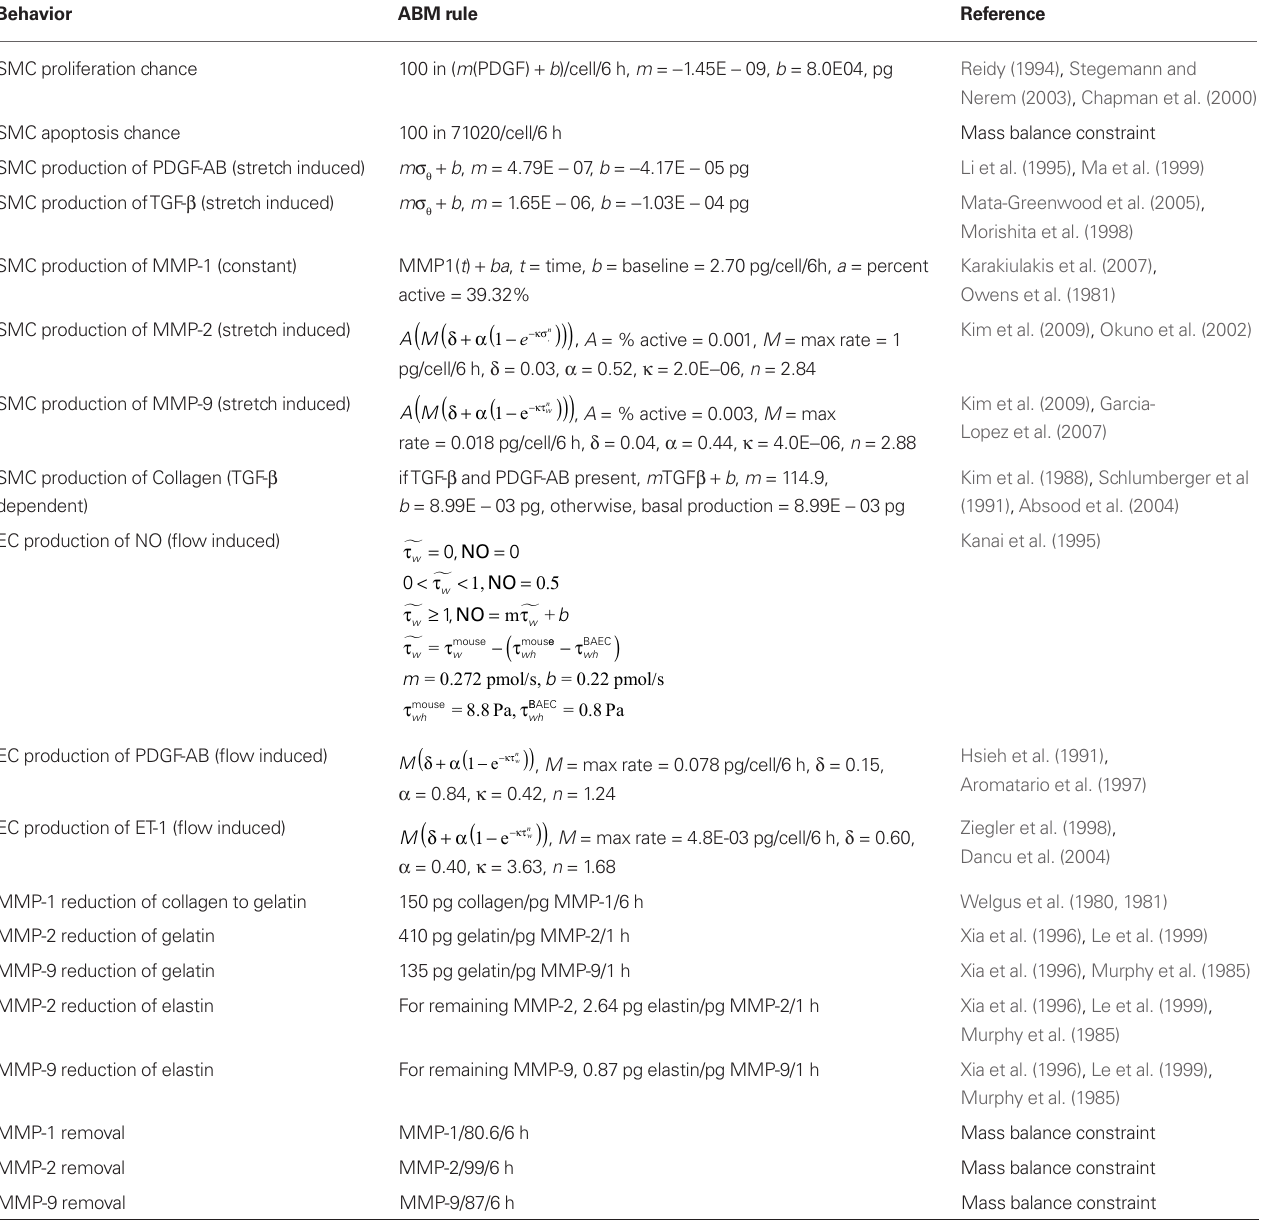
Table 1 | Agent-based model rules.